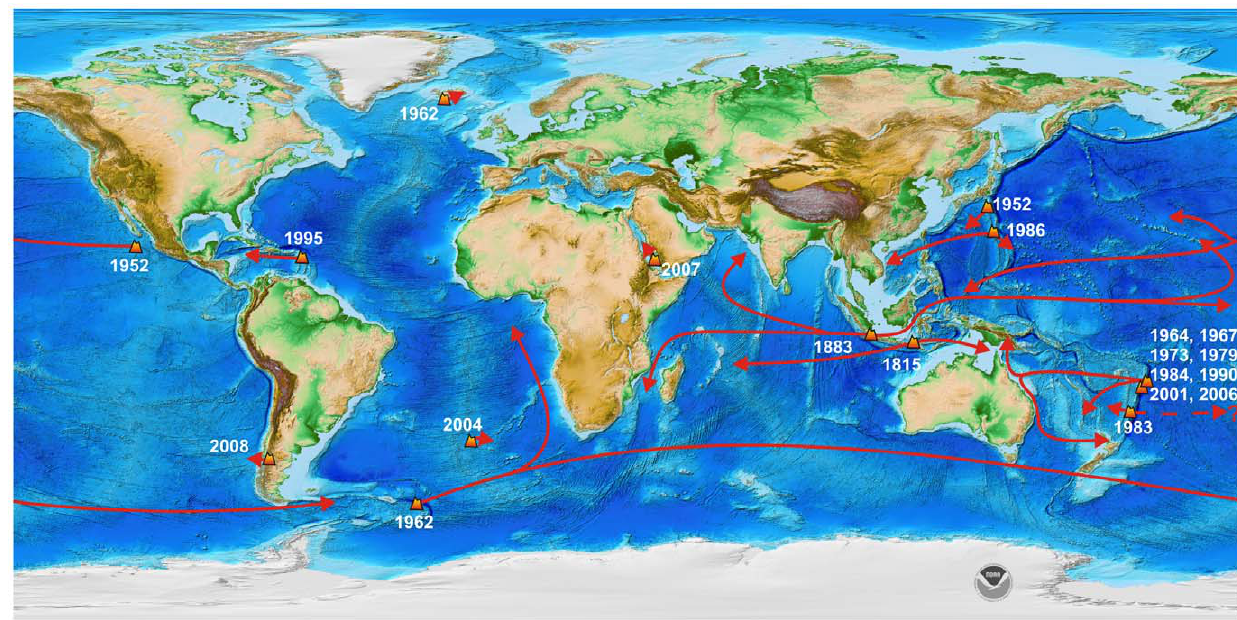
Figure 1. Significant pumice rafting events over the last 200 years. Volcanic eruption locations, eruption dates and general trajectory paths of pumice rafts are shown illustrating the global scale and frequency of such events. To maintain figure clarity, only pumice raft-producing eruptions for the last 50 years from the Tonga-Kermadec arc, (southwest Pacific) are listed. Data sources are given in Supporting Information (Appendix S1) to this paper. Base map is from Amante and Eakins [14].